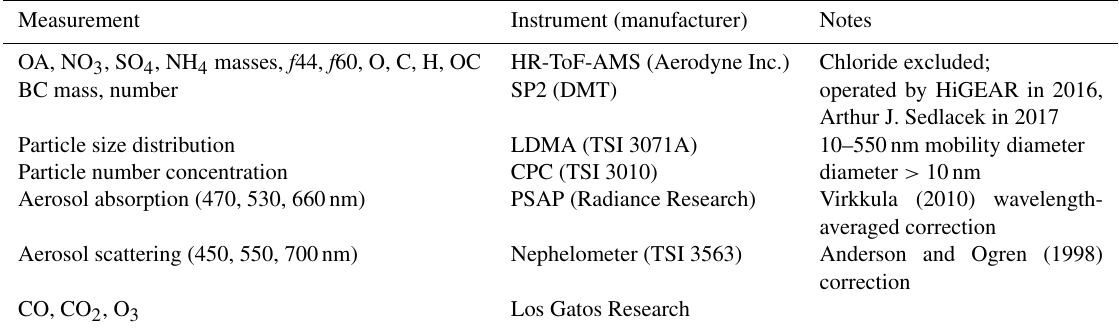
Figure 2. 24 September 2016 flight track with colorized OA : BC mass ratios superimposed on High-Spectral-Resolution Lidar – Generation 2 (HSRL-2) 523nm aerosol backscatter imagery collected along 11 ◦ E by the overflying ER-2 plane, near in time to the P-3 plane’s location at 10 ◦ S. Table 1. Instrument table.